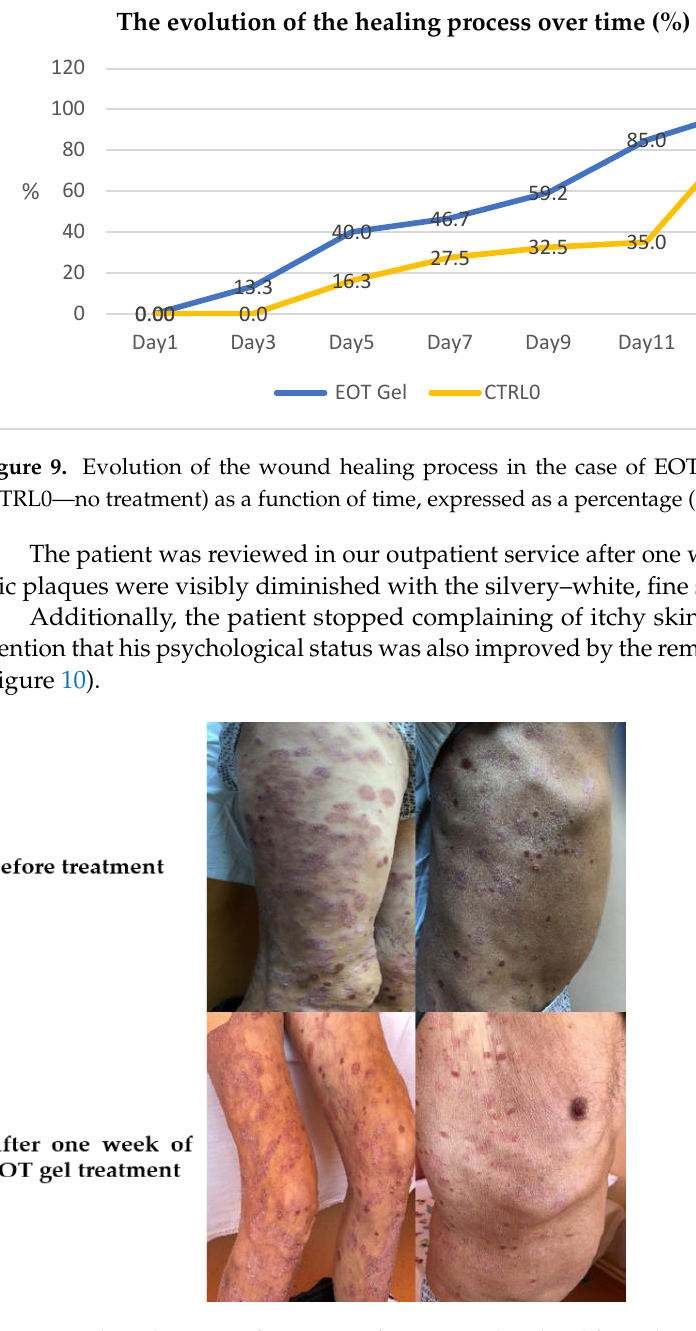
Figure 9. Evolution of the wound healing process in the case of EOT gel compared to control (CTRL0 — no treatment) as a function of time, expressed as a percentage (%).